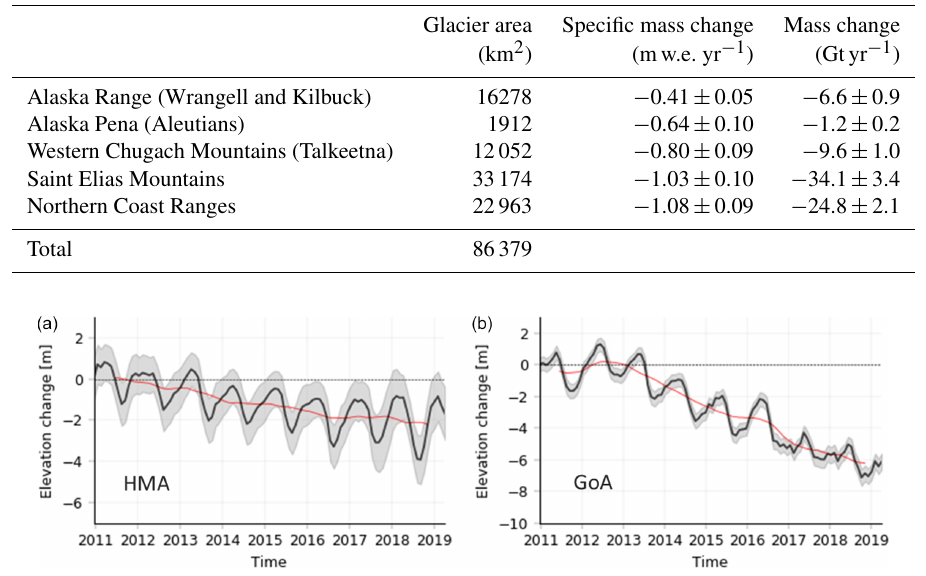
Figure 4. Monthly surface elevation change time series for High Mountain Asia (a) and the Gulf of Alaska (GoA) region (b) . The grey lines display the elevation change time series with the uncertainty envelope. The red line displays a 12-month moving